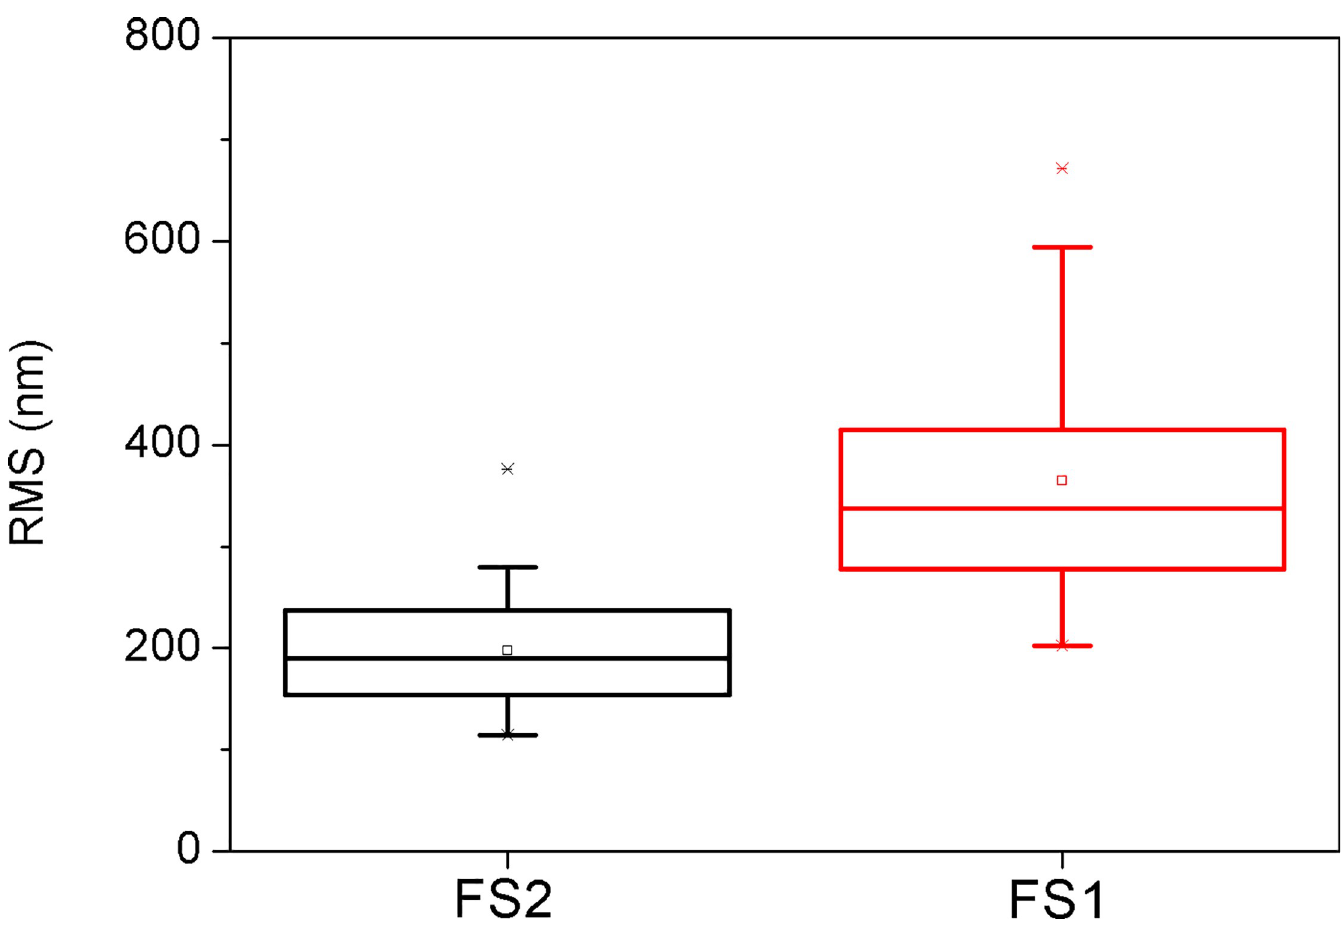
Fig 1. RMS comparison between FS1 and FS2.